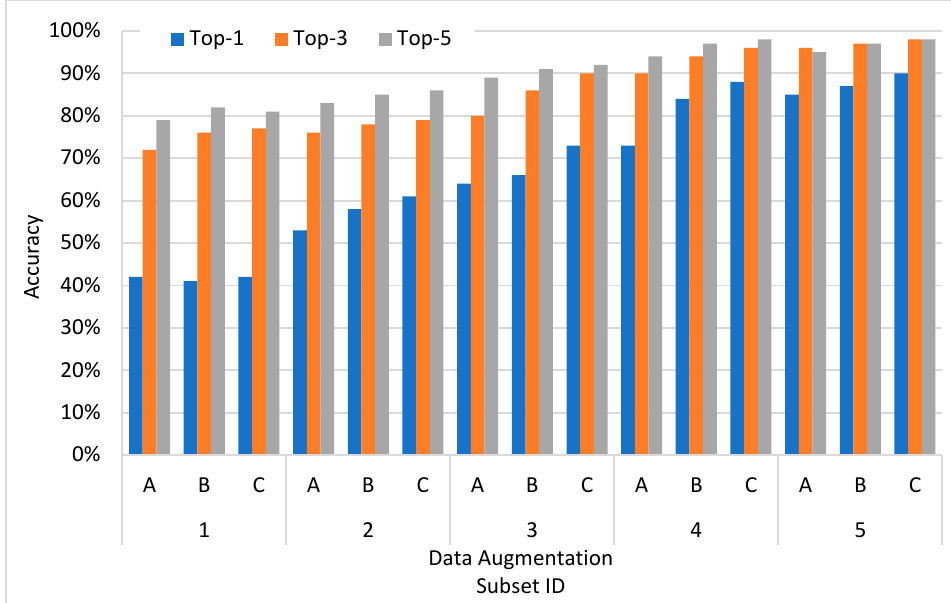
Figure 8. Accuracy of some species with different data enhancement. Note: A, B and C are data enhancement methods, which are the same as those in Table 2. Experimental group 1~5 represent the subsets of the IP102 dataset divided based on the sample quantity. Experimental group 1 represents the subset consisting of the top 20% of classifications with the minimal sample quantity. Similarly, Experimental group 2~5 represent the subsets distributed at 21~40%, 41~60%, 61~80% and 81~100%, respectively.